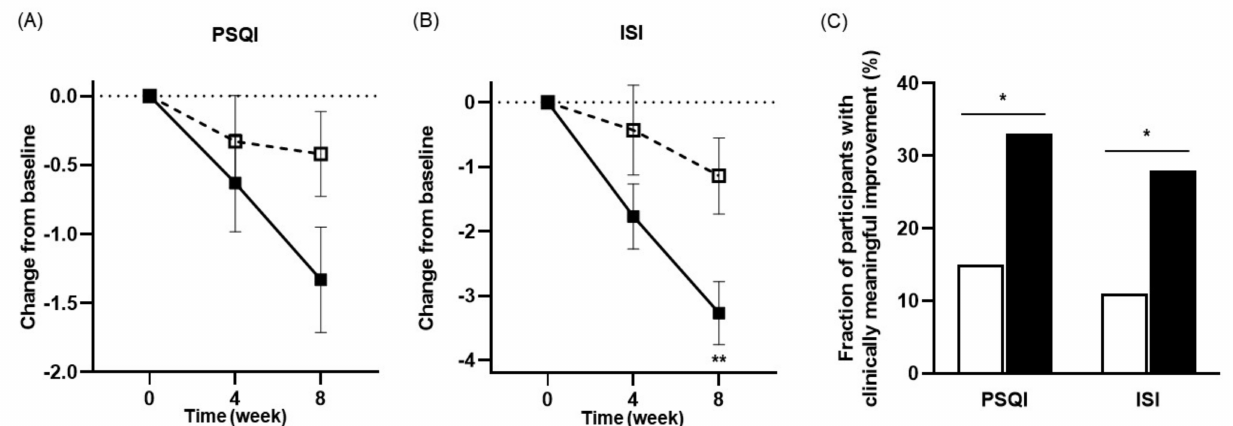
Figure 4. Effects of NVP-1704 on sleep parameters such as the PSQI score ( A ), ISI score ( B ), and the fraction of subjects with improvements in PSQI and ISI scores ( C ). Scores are shown as 4- and 8-week mean changes from baseline during the study period. The improvement is defined as a score reduction above or equal to the minimal clinically important difference for each scale. Independent t -tests were performed for analysis of the PSQI and ISI scores. Chi-squared tests were performed for the comparison of the fraction of participants with improvement. Data values are described as means ± standard errors of the mean. Asterisks indicates a statistically significant difference between the two groups (* p < 0.05, ** p < 0.01). PSQI, Pittsburgh Sleep Quality Index; ISI, Insomnia Severity